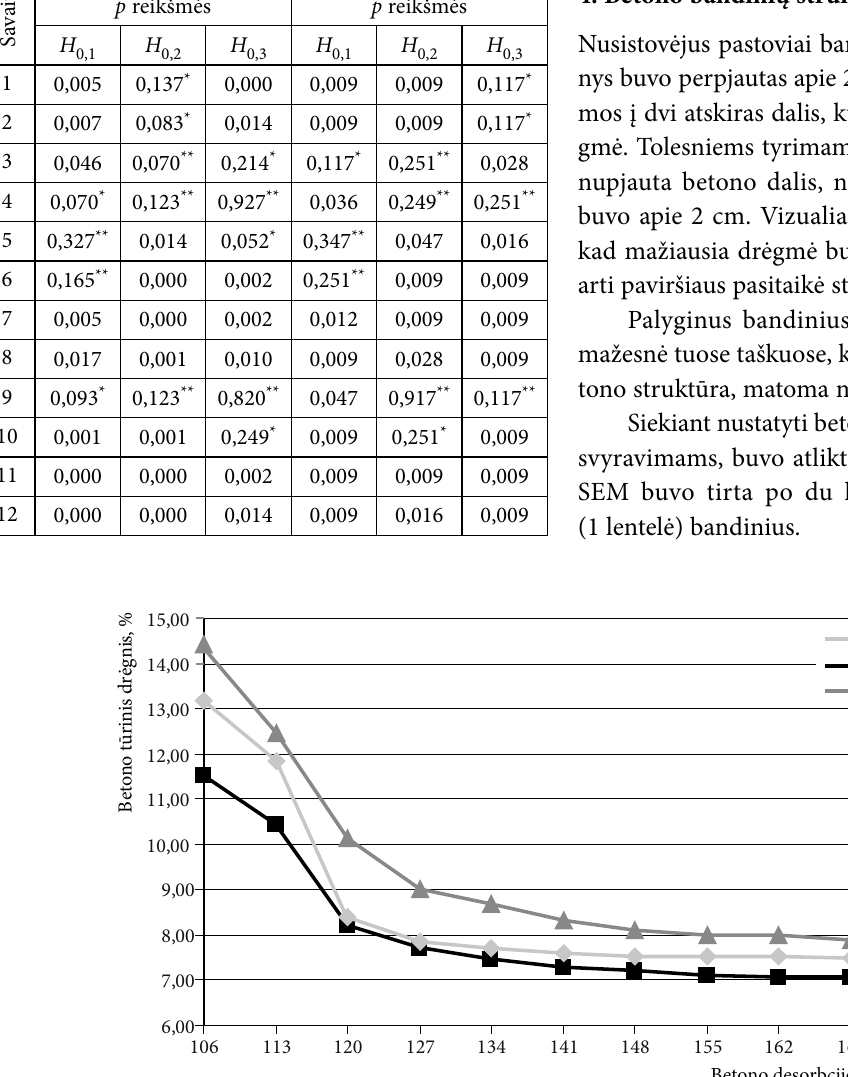
Fig. 7. Changes in concrete moisture under drying stove conditions ( t = +(105 ± 5) ° C)